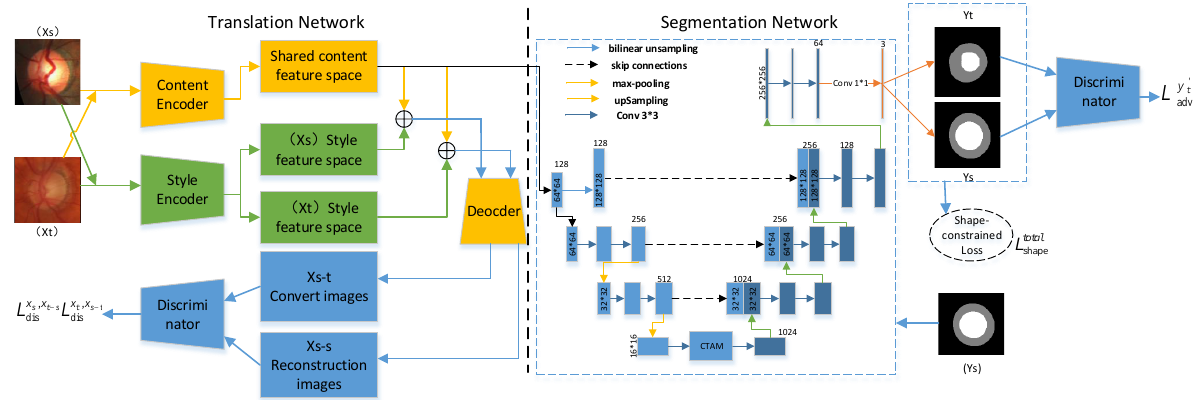
Figure 2. Overview of our proposed SCUDA framework. The left side of the split line is the image translation sub-model and the right side is the image segmentation sub-model; X s − s denotes the reconstructed image dataset and X s − t denotes the converted image dataset, while Y t and Y s denote the segmentation map datasets produced by the splitter network. Additionally, the symbol ⊕ shows the combination of content and style